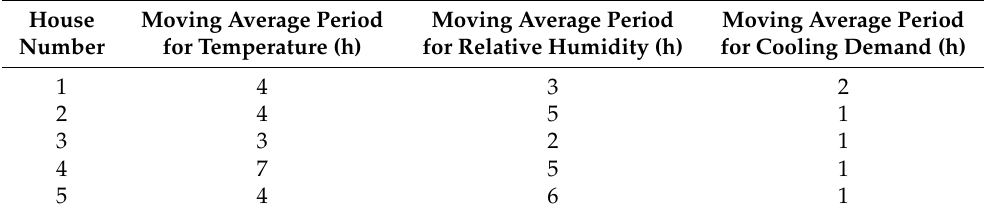
Table 2. List of the optimal interval moving averages for the selected features for each residence.